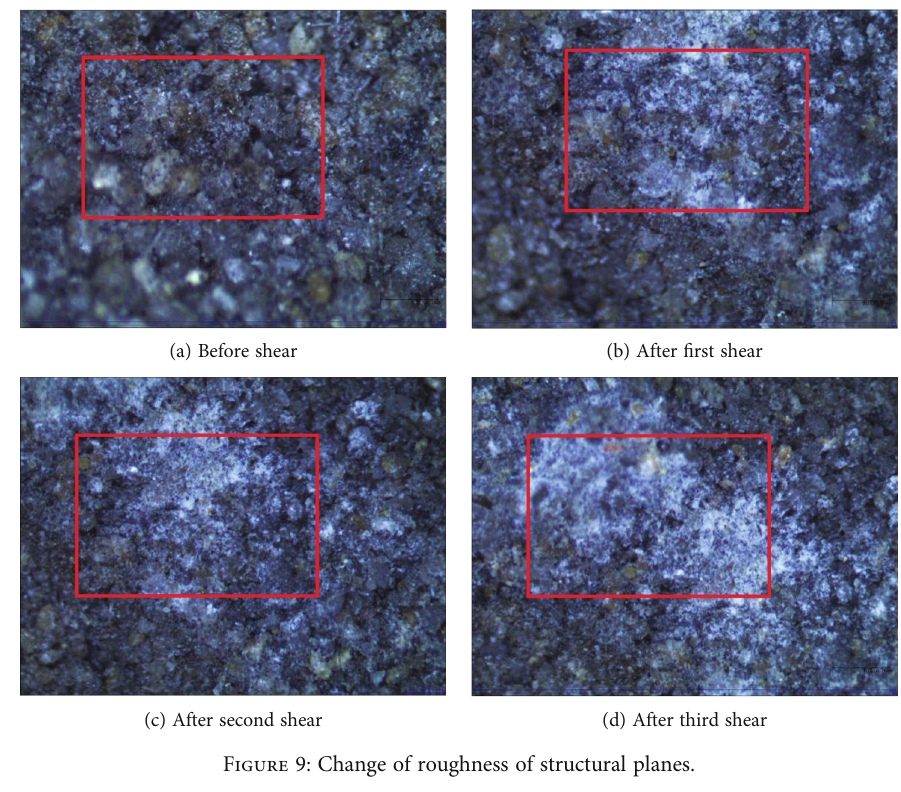
Figure 9: Change of roughness of structural planes.